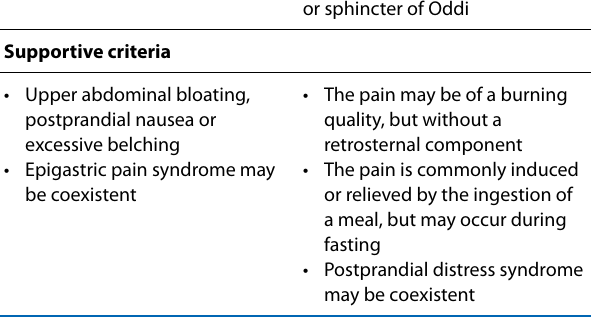
Table 2: Diagnostic criteria for postprandial distress syndrome and epigastric pain syndrome 8 Postprandial distress syndrome Epigastric pain syndrome Troublesome postprandial fullness, after a standard-sized meal, occurring several times per week (at a minimum) And/or Early fullness which prevents a regular meal from being finished, occurring several times per week (at a minimum)